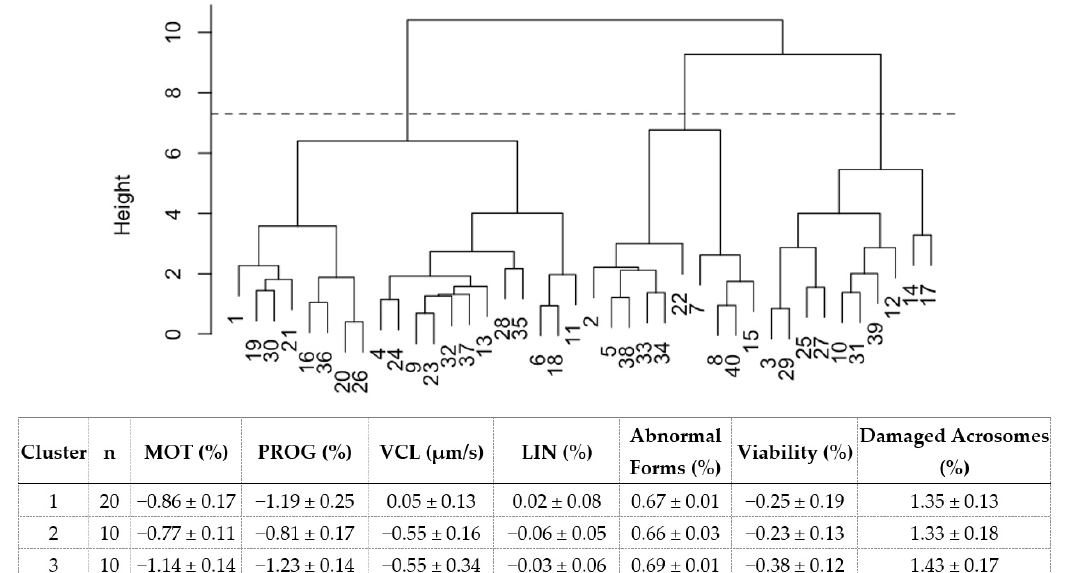
Figure 3. Clustering of the bulls (numbers) according to semen freezability (di ff erence of post-thawing and fresh quality, normalized by their average; negative values indicate a decrease after thawing, positive values indicate an increase, whereas values around 0 indicate no change). Total motility, progressivity, VCL, WOB, and damaged acrosomes were selected as the most informative and uncorrelated variables for this clustering. The table shows medians ± MAD (median absolute deviation) for each group.